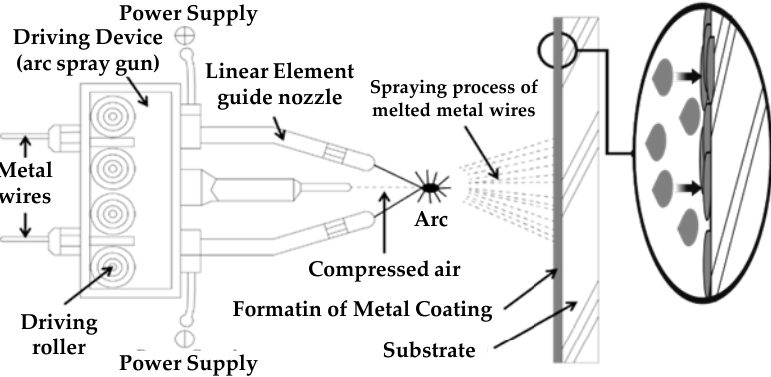
Figure 1. Schematic of arc thermal metal spray system.